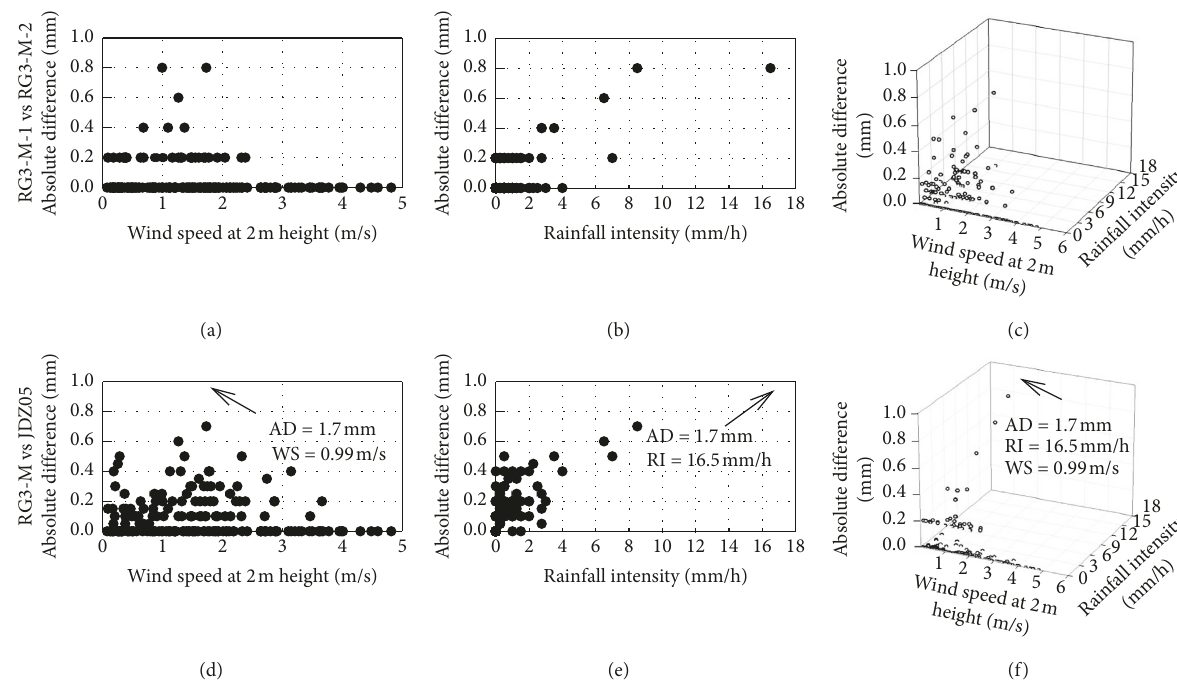
Figure 7: Scatterplots of hourly absolute difference between two tested RG3-M gauges with variation of (a) wind speed and (b) rain intensity, respectively, and (c) three-dimension relationship of the three variables (hourly absolute difference, wind speed, and rain in- tensity). (d), (e), and (f) correspond to (a), (b), and (c), respectively, but for averaged hourly difference between the RG3-M gauge and the JDZ05